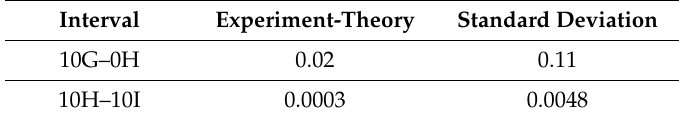
Table 10. Comparison level energy di ff erence in megahertz between theory and measurements. Interval Experiment-Theory Standard